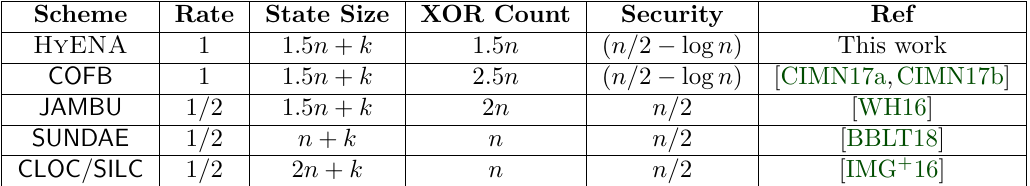
Table 1: Comparison between AE modes using an n -bit block cipher with k -bit